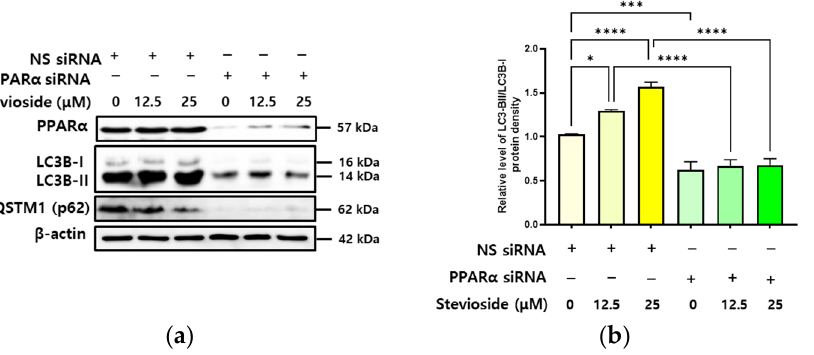
Figure 6. Stevioside-induced autophagy is dependent on PPAR α in hepatocytes. HepG2 cells were transfected with the nonspecific (NS) siRNA or peroxisome proliferator-activated receptor α (PPAR α ) siRNA. After 24 h, the cells were treated with different concentration of stevioside (SS; 0, 12.5, and 25 μ M) for another 24 h. ( a ) Immunoblot analysis of PPAR α , microtubule-associated protein light chain 3B (LC3B)-II/LC3B-I, sequestosome1 (SQSTM1), and β -actin. ( b ) Relative expression of LC3B-II/LC3B-I. ( c ) Relative expression of SQSTM1(p62)/ β -actin. All data are presented as the mean ± SE and represent results from three independent experiments. * p < 0.05, *** p < 0.001, and **** p < 0.0001.